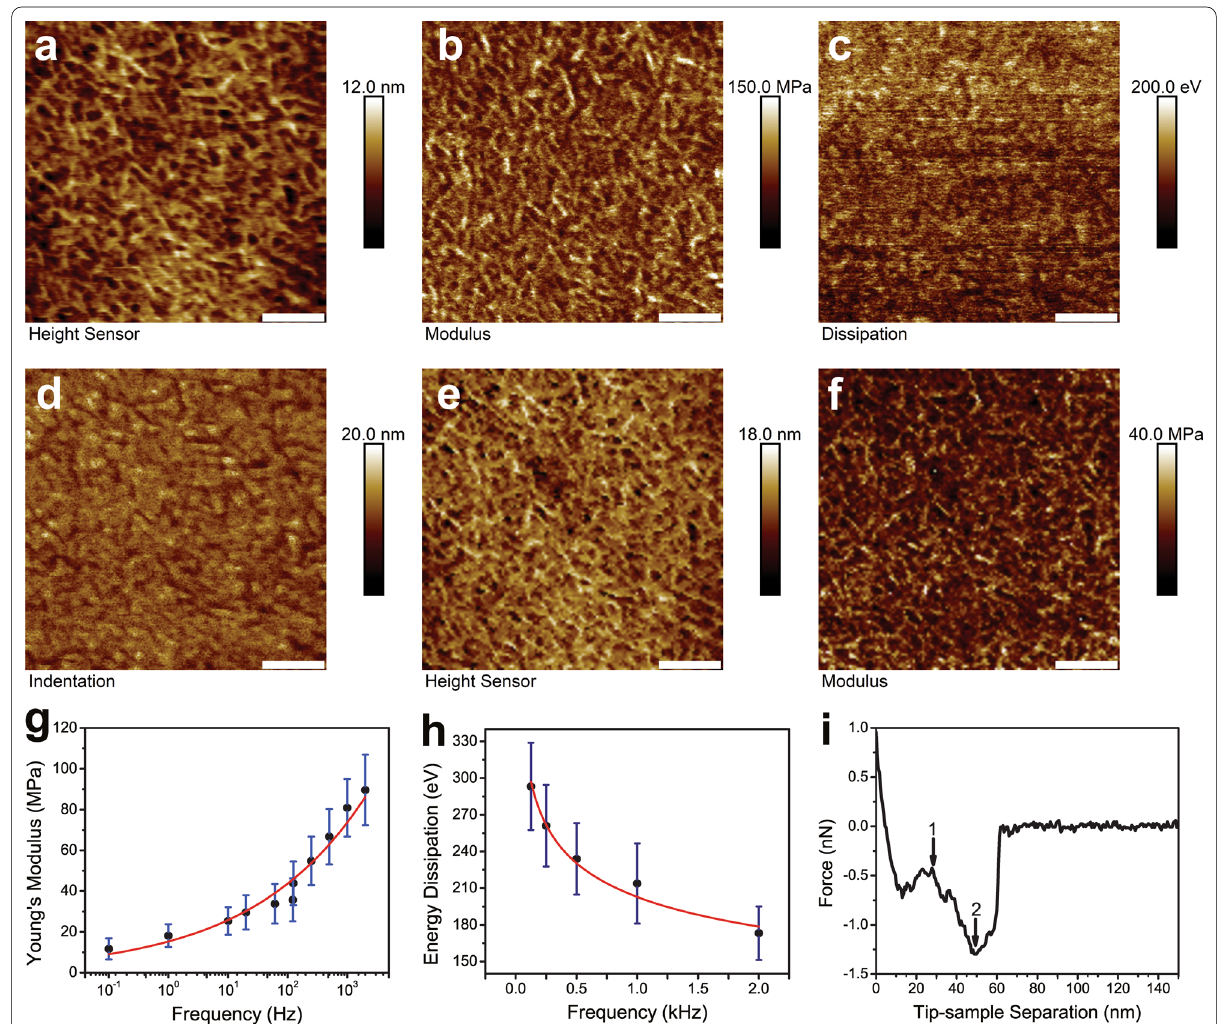
Fig. 3 Mechanical property of LDPE sample mapped at different frequencies. Panels a – d were height sensor image, DMT modulus channel, energy dissipation, and indentation channel captured with PFQNM at 2 kHz on neat LDPE region. Surface roughness of the height sensor image was reported in the form of R q as 2.58 0.35 nm. Panels e and f were height sensor image and DMT modulus channel captured with FFV at 122 Hz ± on neat LDPE region. For images a – f , the scale bars represented 100 nm. Relationship between measured Young’s modulus ( E ) and the force mapping frequency ( f ) was plotted in g . The measured Young’s moduli at different frequencies were tabulated in Table 1. The data were fitted with f 0.23 ( R 2 15.31 a power function yielded E 0.96). The relationship between energy dissipation ( E diss ) and different mapping frequencies ( f ) = × = was shown in panel h . The energy dissipation values obtained at 2 kHz, 1 kHz, 0.5 kHz, 0.25 kHz and 0.125 kHz were 173.2 233.9 29.3 eV, 261.1 33.5 eV, 293.2 35.6 eV, respectively. The data were fitted with a power function yielded E diss ± ± ± A representative F-D curve showed two distinct ruptures of AFM tip from LDPE sample surface (panel i ). The occurrence of multiple ruptures